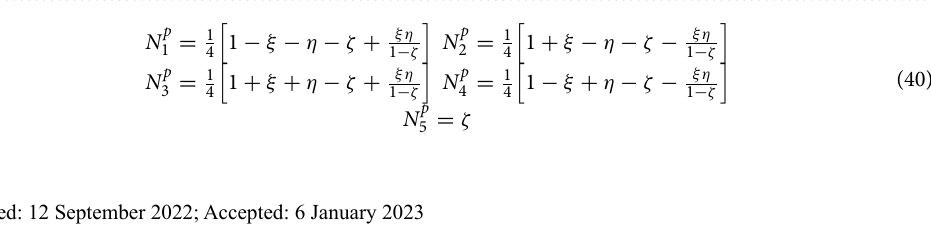
Figure 17. MT response calculation results of different meshes on survey line 2 to the terrain undulation model. ( a ) and ( b ) represent the MT response of the xy and yx components, respectively. ( a 1) and ( b 1) represent the apparent resistivity, and ( a 2) and ( b 2) represent the phase